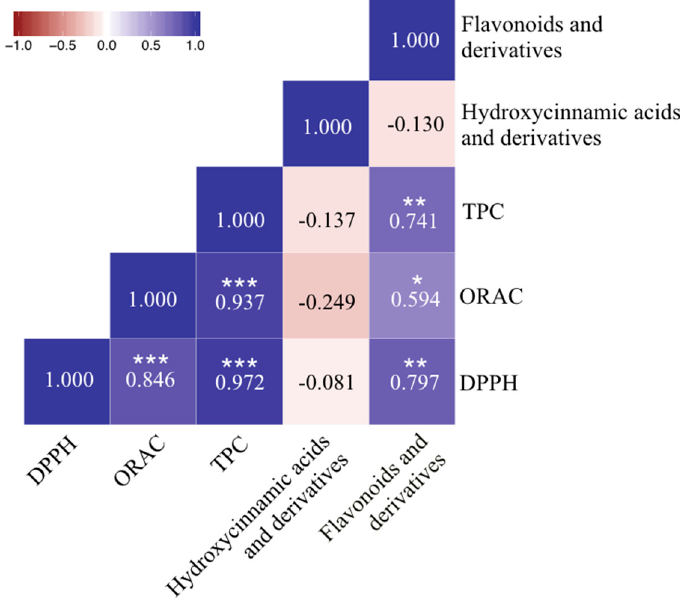
Figure 3. Spearman’s correlation coefficients (two-tailed) for the relationships between antioxidant capacity (DPPH and ORAC), TPC, hydroxycinnamic acids and derivatives, and flavonoids and derivatives in cruciferous vegetables. * Correlation is significant at 0.01 ≤ p < 0.05; ** Correlation is significant at 0.001 ≤ p < 0.01; *** Correlation is significant at p < 0.001.